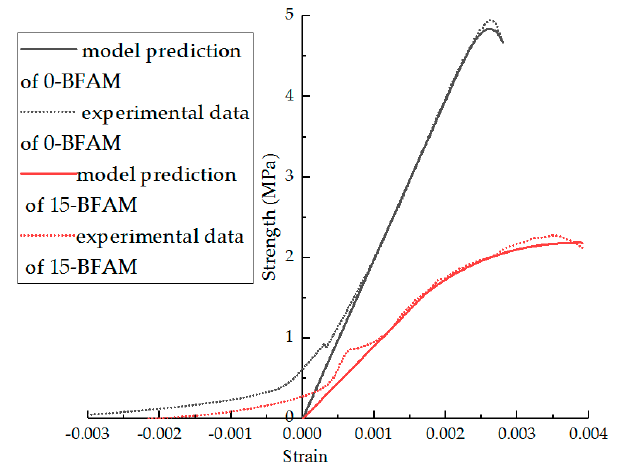
Figure 22. Comparison of experimental data and model predictions for BFAM under F–T cycles.